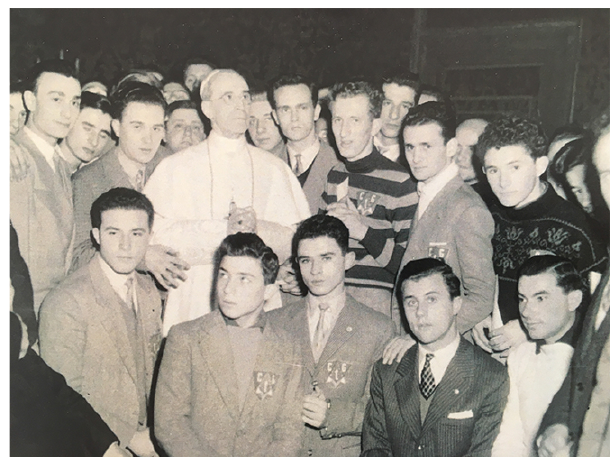
Figure 7: Giorgio Dall’Aglio (first from left on the bottom row) with Pope Pio XII in 1952 in Rome.